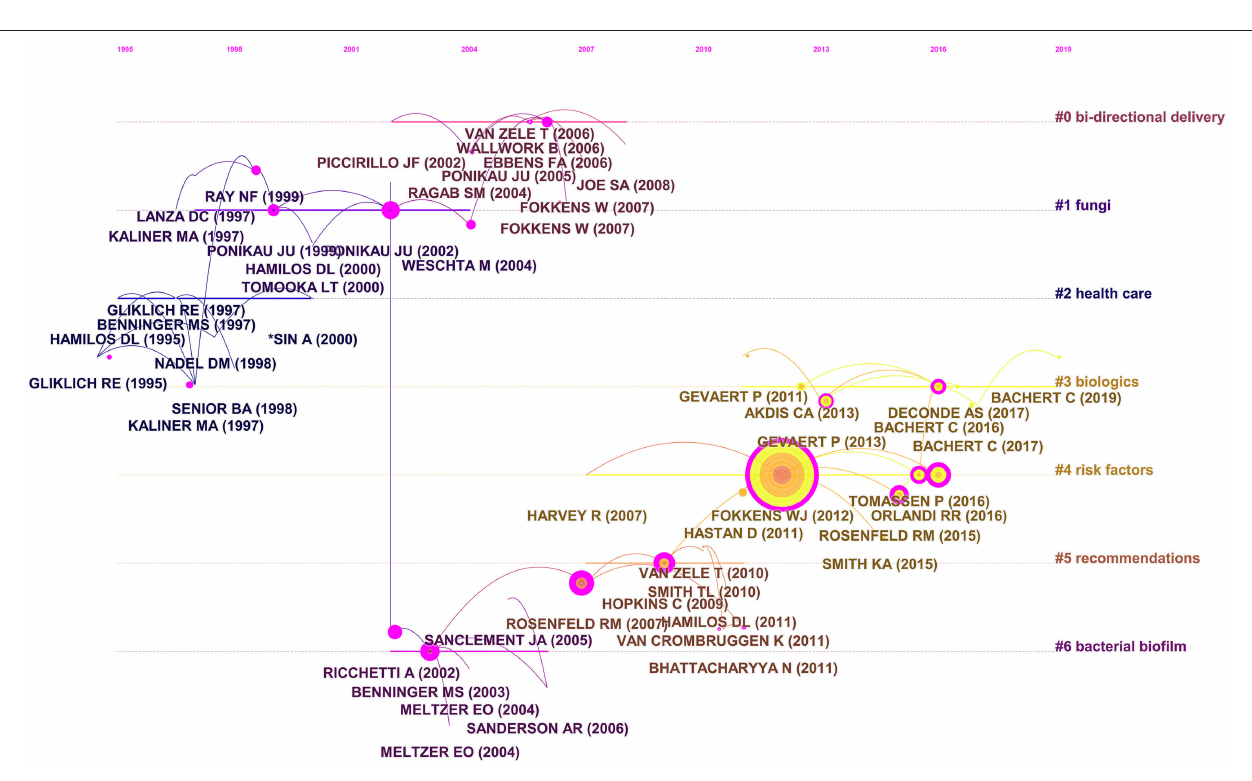
FIGURE 7 | Timeline view of co-cited clusters with cluster